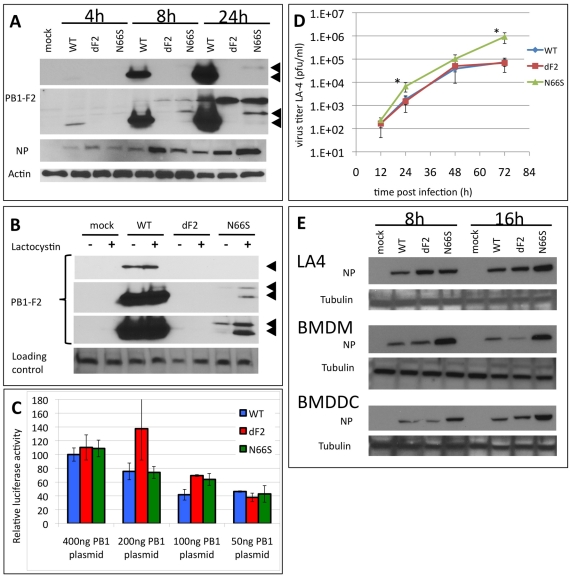
Effects of PB1-F2 expression on replication of A/Viet Nam/1203/2004 in murine cells in vitro.A) Time course of viral protein expression. Murine lung epithelial cells (LA-4) were infected with 2MOI of A/Viet Nam/1203/2004 wild type, dF2 or N66S. Cells were lysed after indicated time points. Whole cell extracts were analyzed by western blot with specific antibodies against PB1-F2 (upper two panels, short and long exposure, respectively, PB1-F2 is indicated by black arrows), viral nucleoprotein (NP) or beta-Actin. B) PB1-F2 expression in presence or absence of 10 µM lactocystin. LA4 were infected with 2MOI of A/Viet Nam/1203/2004 wild type, dF2 or N66S. Cells were lysed after 24 h. Whole cell extracts were analyzed by western blot with specific antibodies against PB1-F2 (upper three panels, short, medium and long exposure, respectively, PB1-F2 is indicated by black arrows), equal loading is indicated by an unspecific background band (lower panel). C) Polymerase Assay. Murine fibroblasts (3T3) were transfected with indicated amounts of pCAGGS-PB1 A/Viet Nam/1203/2004 wild type (blue), dF2 (red) or N66S (green) and constant amounts of PB2, PA, NP and reporter gene expressing plasmids as described in Material and Methods. Mean firefly-luciferase activity of three independent transfections normalized to renilla-luciferase activity is depicted. Error bars represent SD. No significant differences were detected. D) Multi-cycle growth curve of A/Viet Nam/1203/2004 wild type (blue), dF2 (red) or N66S (green) on LA-4. Cells were infected with 0.05MOI of virus. Viral supernatants were taken at the indicated time points. Viral titers were determined by standard plaque assay on MDCK in absence of trypsin. Mean pfu/ml of independent triplicates ±SD indicated by the error bar are depicted. P-values are indicated (*p<0.05) using WT as standard. E) Time course of viral protein expression in LA-4 (upper panel), bone marrow derived macrophages (BMDM, middle panel) and bone marrow derived dendritic cells (BMDDC). Cells were infected with 2MOI of A/Viet Nam/1203/2004 wild type, dF2 or N66S and lysed after indicated time points. Whole cell extracts were analyzed by western blot with specific antibodies against viral nucleoprotein (NP) and tubulin.